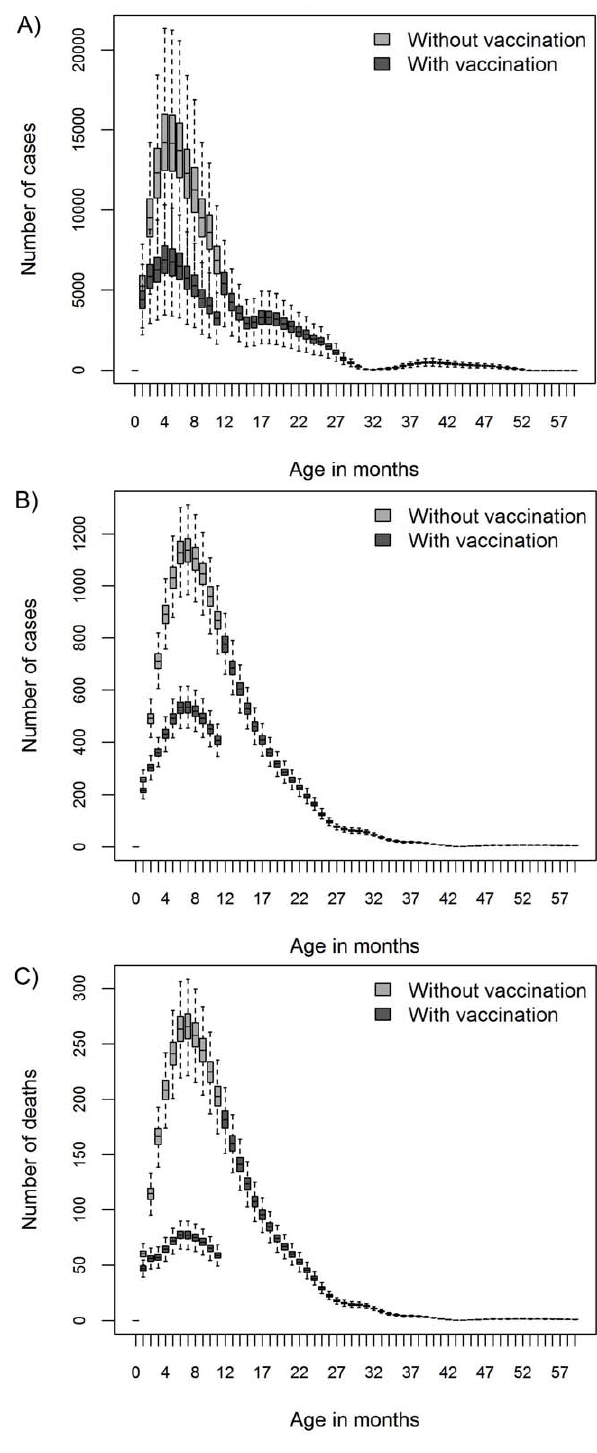
Figure 2. The health care use associated with rotavirus in Kenya, by month of age, observed before (light grey bars) and predicted after (dark grey bars) introduction of a rotavirus vaccine. The panels represent the number of outpatient clinic visits (panel a), hospital admissions (b) and deaths (c). The figures are representative for both Rotarix and RotaTeq as an identical efficacy was assumed.